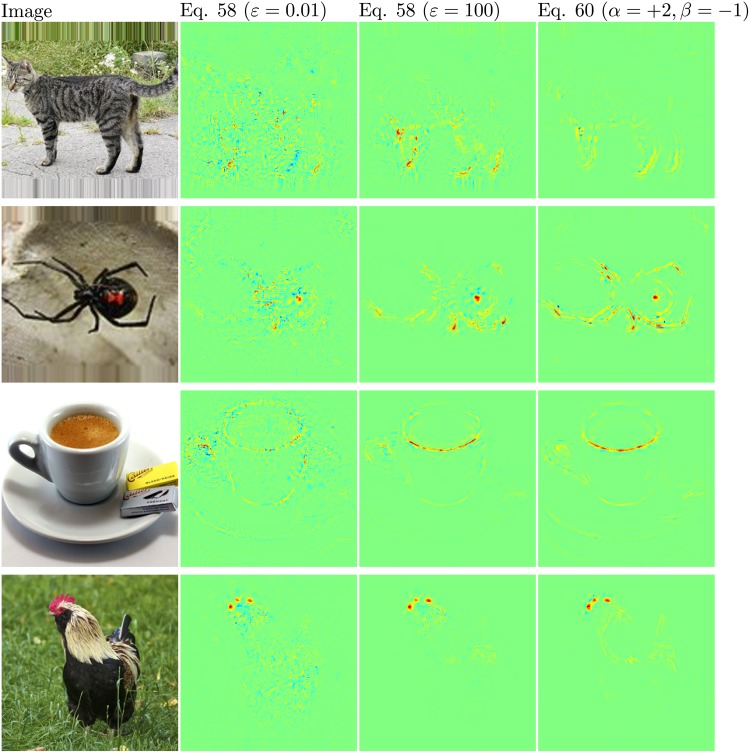
The pixel-wise decompositions for examples images of the neural net pre-trained on ILSVRC data set images and provided by the Caffe open source package [60].Second column shows decompositions computed by Formula (58) with stabilizers ɛ = 0.01, the third column with stabilizers ɛ = 100, the fourth column was computed by Formula (60) using α = +2, β = −1. The artifacts at the edges of the images are caused by filling the image with locally constant values which comes from the requirement to input square sub-parts of images into the neural net. Pictures in order of appearance from Wikimedia Commons by authors Jens Nietschmann, Shenrich91, Sandstein, Jörg Hempel.